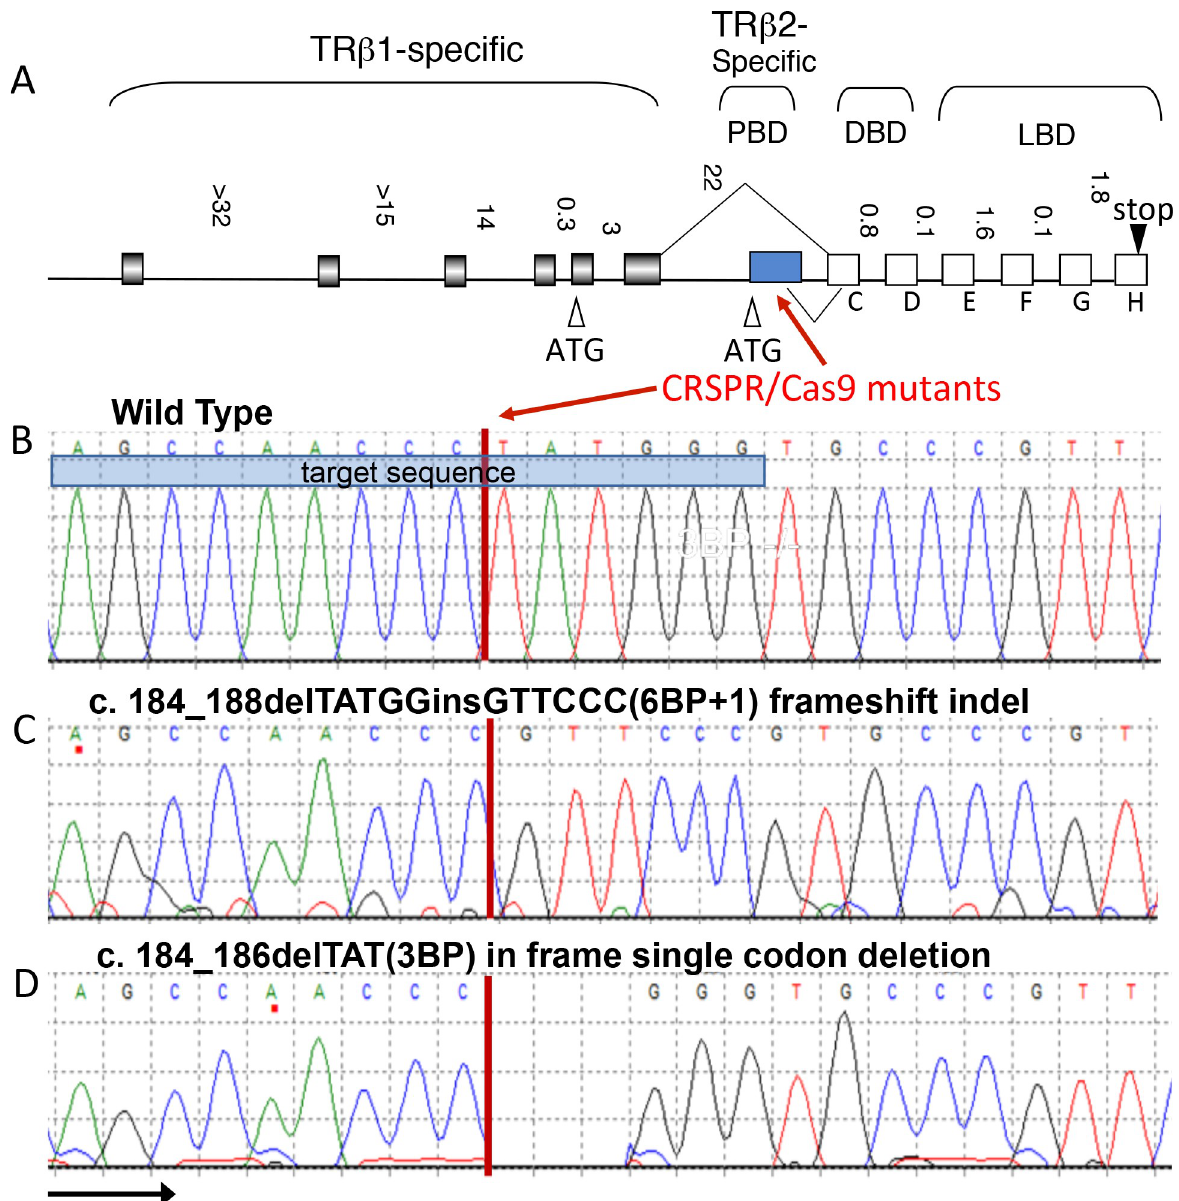
Fig 1. Two CRISPR mutant lines. (A) Both mutations are in the first exon of the tr β 2 isoform within the N-terminus in the protein binding domain (PBD). Modified from Jones et al. (2003) [14] with permission of Thyroid , Mary Ann Liebert, Inc., publishers, New Rochelle, NY. (B-D) Both mutations targeted the TAT codon resulting in a frameshift indel ( 6BP+1 ) and an in-frame codon deletion ( 3BP ). DNA binding domain (DBD), ligand binding domain (LBD). heterozygous in-cross. Despite the absence of the highly conserved tyrosine, the 3BP tr β 2 pro- tein activates the tr β 2 reporter.